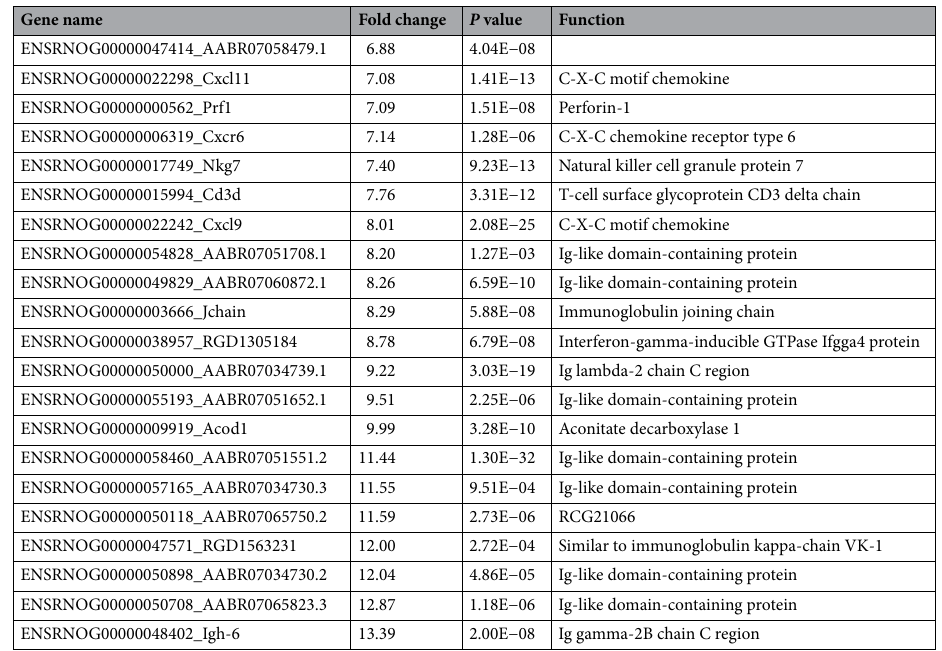
Table 1. Genes differently expressed in intracranial versus subcutaneous control animals. All of the most differently expressed genes were upregulated in subcutaneous controls versus intracranial control animals.